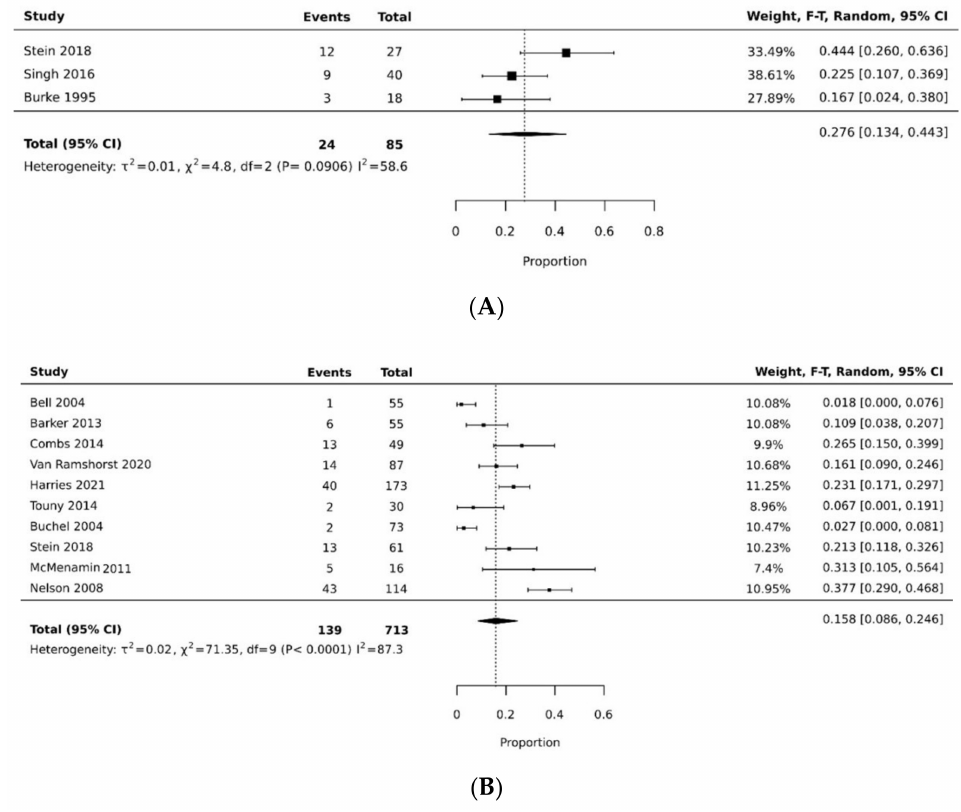
Figure 4. ( A ) Forest plot for donor site dehiscence for gracilis [21,35]. ( B ) Forest plot for donor site dehiscence for VRAM [26,29,30,34].